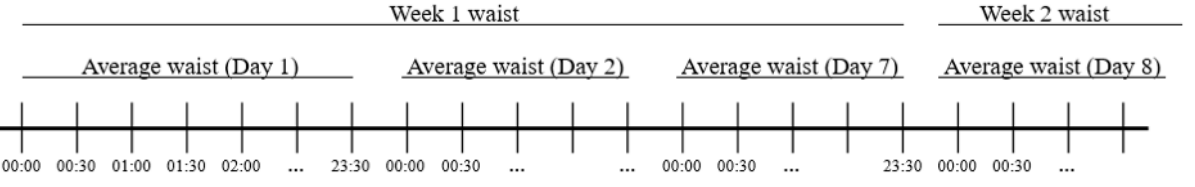
Figure 3. Calculations of daily and weekly waist circumferences. The first week was the baseline